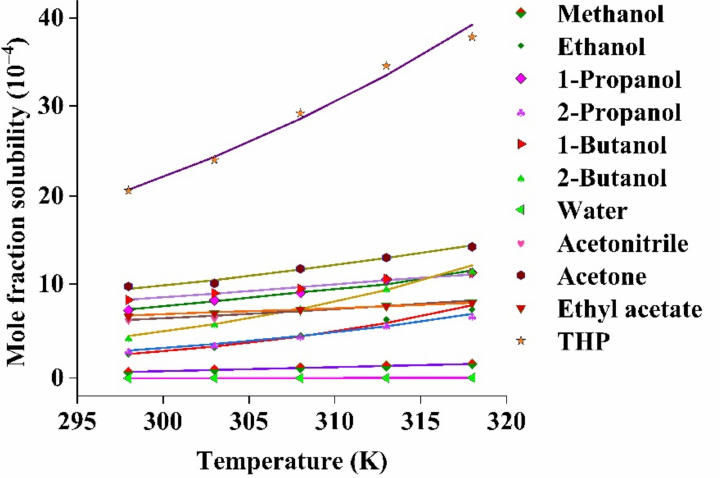
Figure 3. Experimental and calculated mole fraction solubility of the drug in organic solvents based on BKM. Solid lines denote the calculated